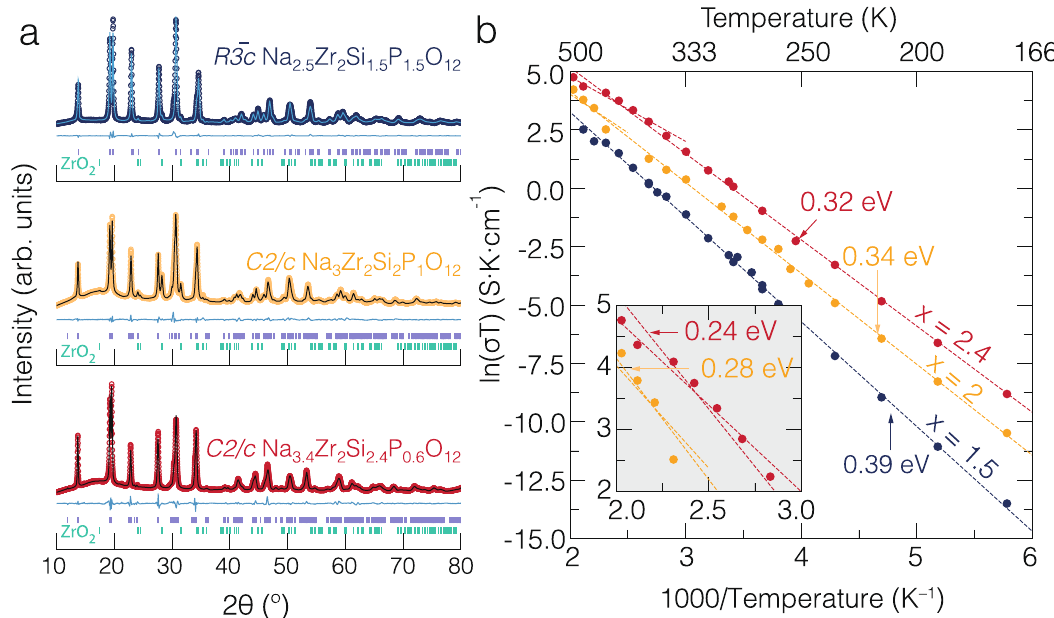
Fig. 4 | Powder X-ray diffraction results for selected NASICON compounds at 298K and their ionic conductivities measured using pellets. In panel a , pow- der X-Ray diffraction patterns (dark blue, orange, and red circles) and Rietveld re fi nements(solidlinesincyan,darkbrownanddarkred)forNa 1+ x Zr 2 Si x P 3 − x O 12 ( x = 1.5, 2.0, and 2.4) are shown. b Arrhenius plots from